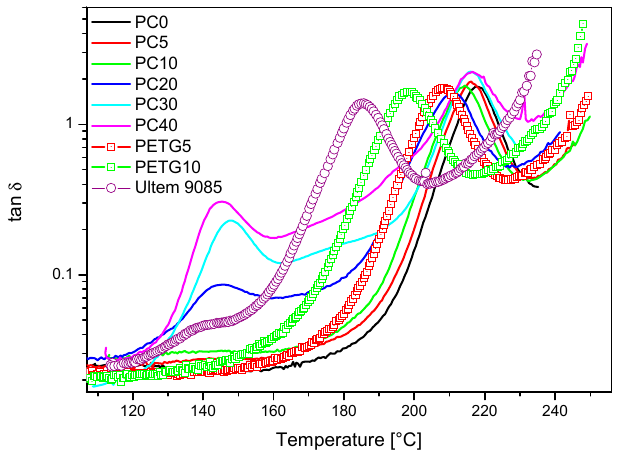
Figure 5. Tan δ versus temperature for PEI/PC and PEI/PETG blends compared to Ultem 9085: effect of PC and PETG content.